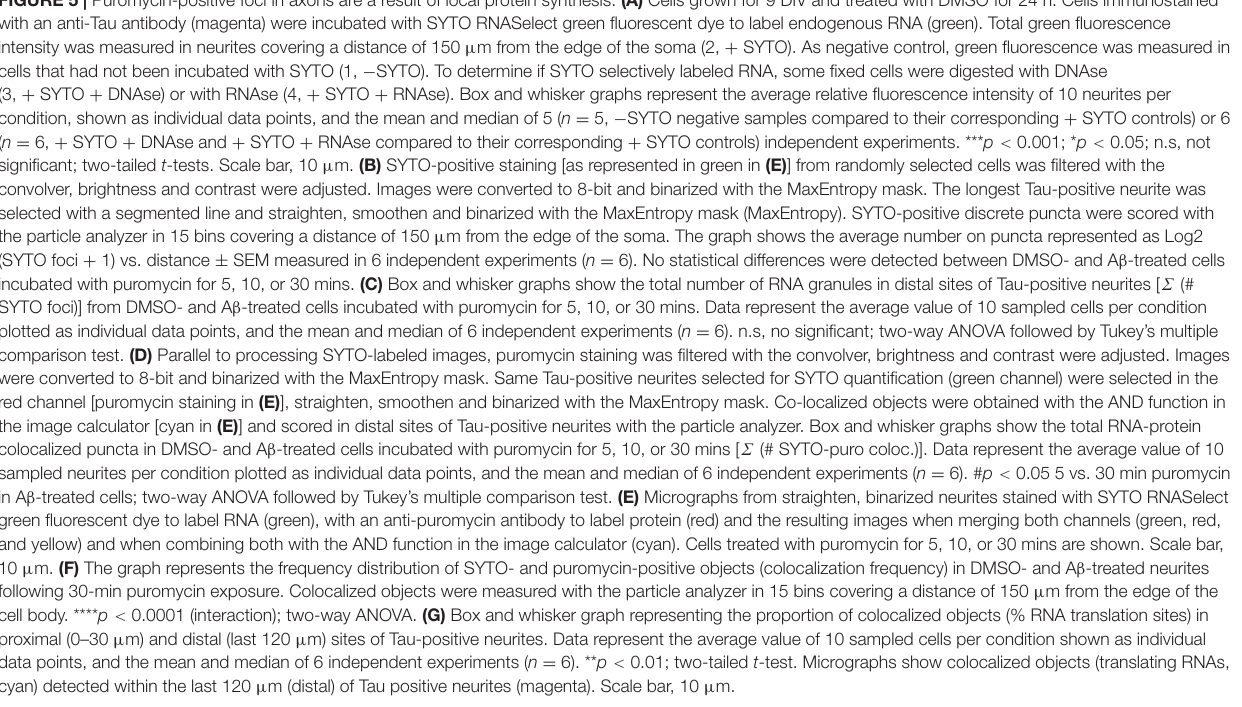
workflow B): images were convolved with the default normalized kernel in FIJI/ImageJ, minimum and maximum intensity values were adjusted, 16-bit images were converted to 8-bit and binarized using the MaxEntropy mask. Neurites were